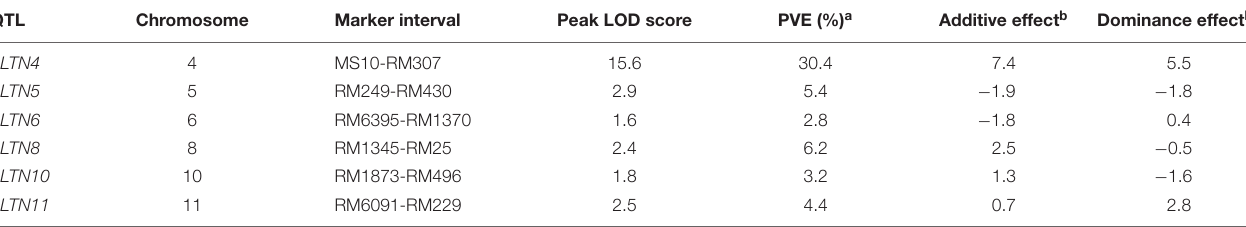
TABLE 1 | The QTL for tiller number identified in an F 2 population derived from a cross between “Takanari” and low-tillering line. QTL Chromosome Marker interval Peak LOD score PVE (%) a